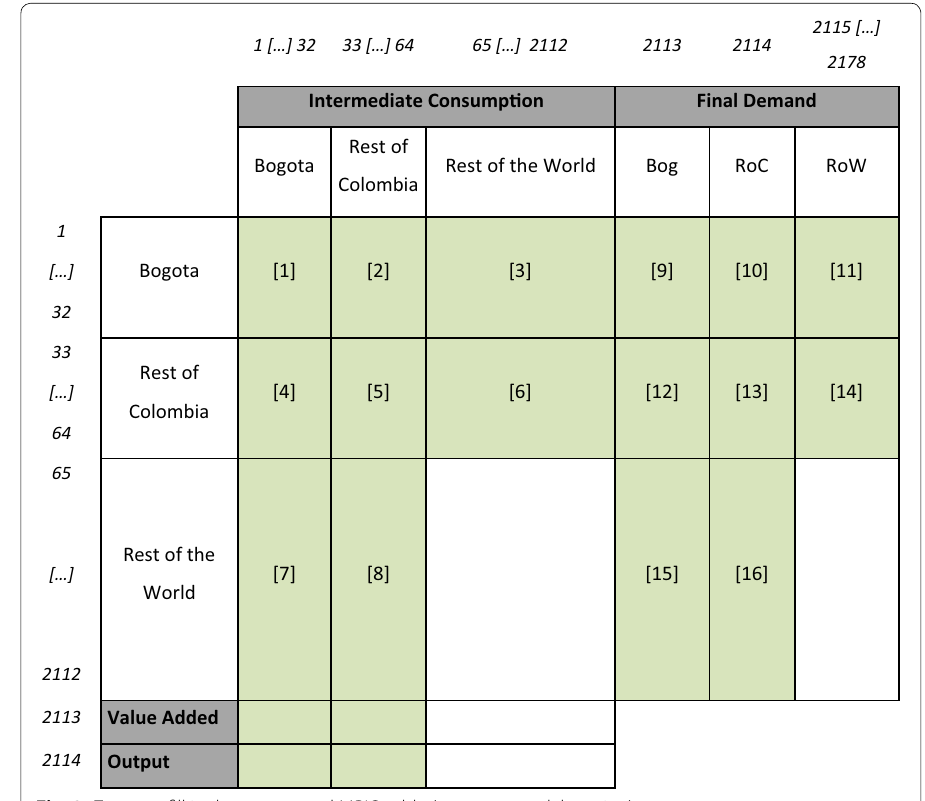
Fig. 3 Zones to fill in the augmented MRIO table (source: own